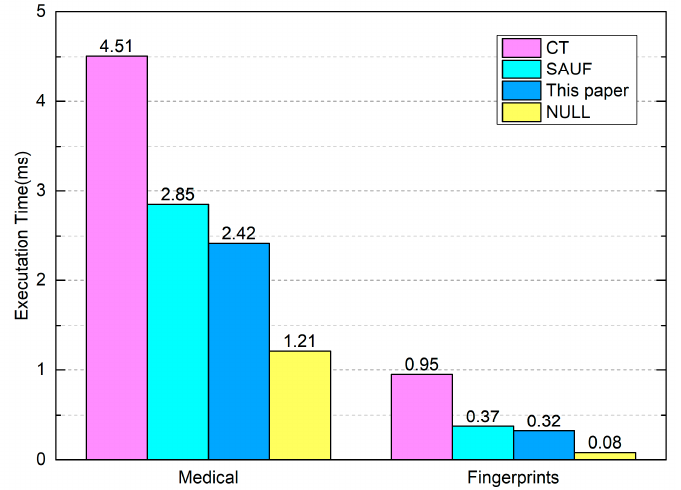
Figure 17. Experimental comparison of CF, SAUF, and NULL.